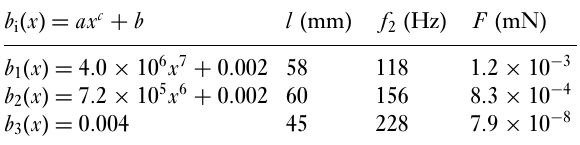
Figure 14 The experimental set-up for robot fish: 1, ultrasonic sensor; 2, robot fish; 3, magnetic coils; 4, pipe; 5, table; 6, step motor; 7, screw; and 8, voltmeter. Table 3 Fin shapes for verification experiments